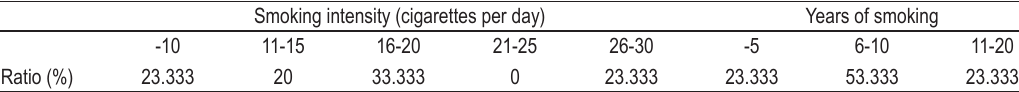
TABLE 1. Distribution of smokers by the intensity and years of smoking Smoking intensity (cigarettes per